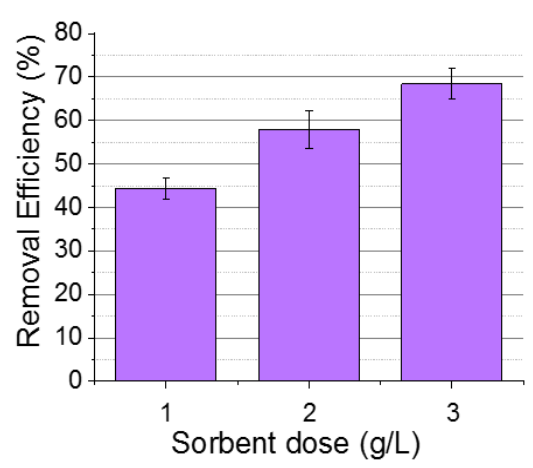
Figure 4. E ff ect of the sorbent dose in the removal e ffi ciency of NPs (C 0 : 25 mg / L; pH 3.5). Figure 4. Effect of the sorbent dose in the removal efficiency of NPs (C 0 : 25 mg/L; pH 3.5).